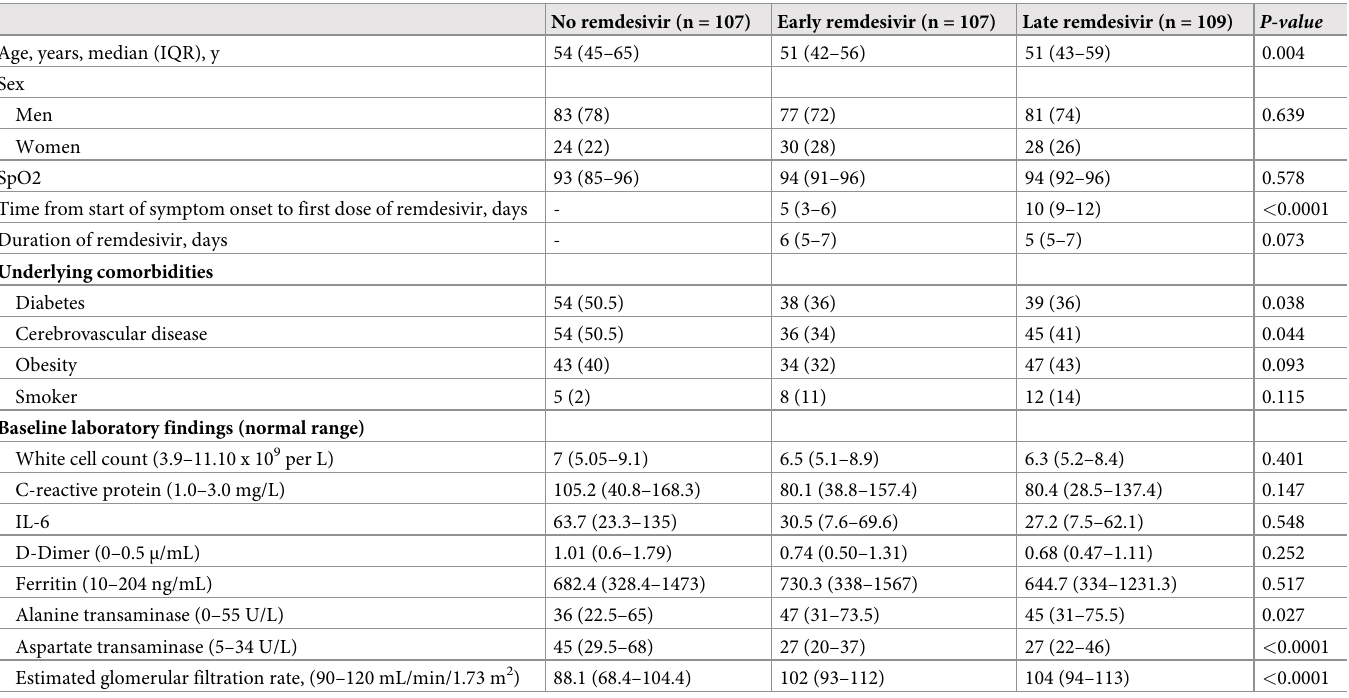
Table 1. Baseline clinical characteristics of the study population.